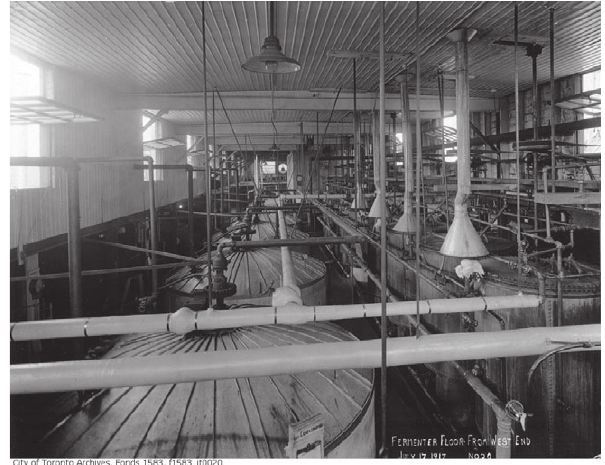
Figure 1 Fermenters in the British Acetones Toronto ABE plant, 1916. Picture courtesy of the City of Toronto Archives.